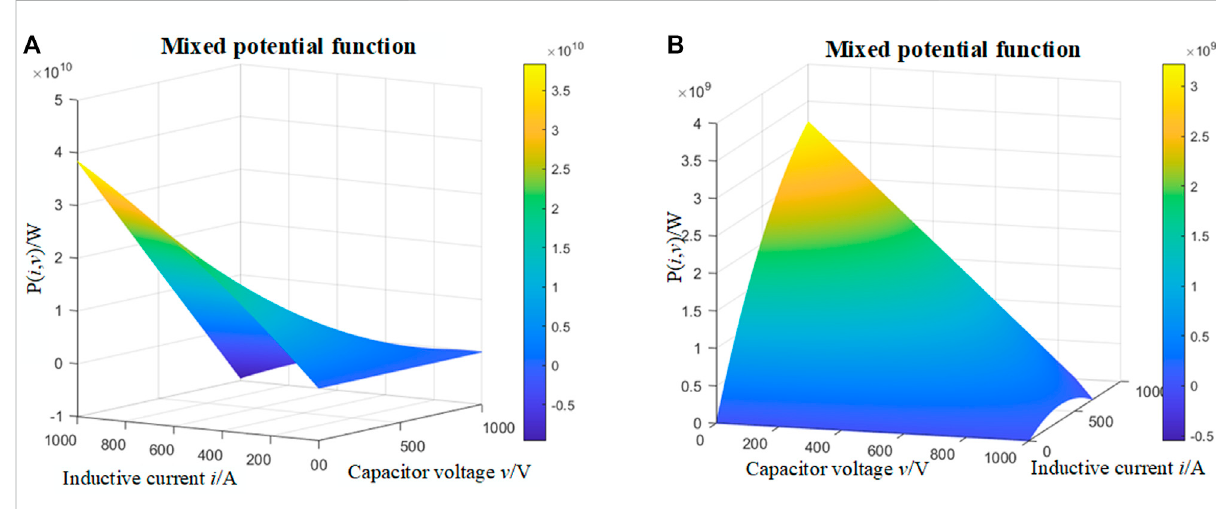
FIGURE 4 Mixed potential function under PI control and VDM control. (A) P ( i , v ) under PI control. (B) P ( i , v ) under VDM